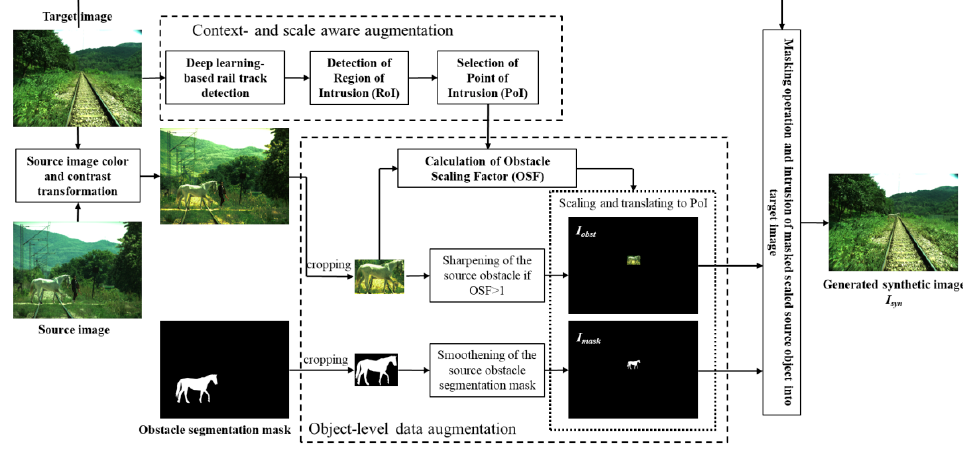
Figure 2. Block-diagram of proposed system for generation of synthetic image for obstacle detection in railways.